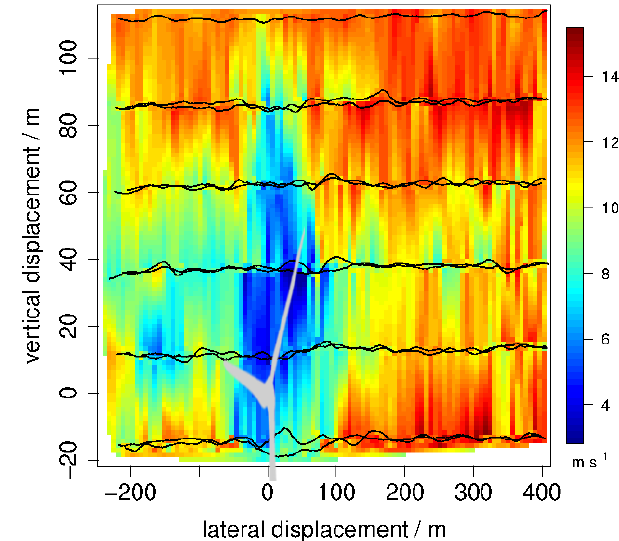
Figure 7. Wind speed measurement from RPA MASC in the wake of a K110 WEC. Flight legs (black lines) are performed perpendic- ular to the main wind direction, four rotor diameters downstream of the WEC, in six distinct altitudes. Linear interpolation was applied between the wind speed measurement of the single legs and visual- ized with a colour scale. The position of the WEC is illustrated by the gray shade.